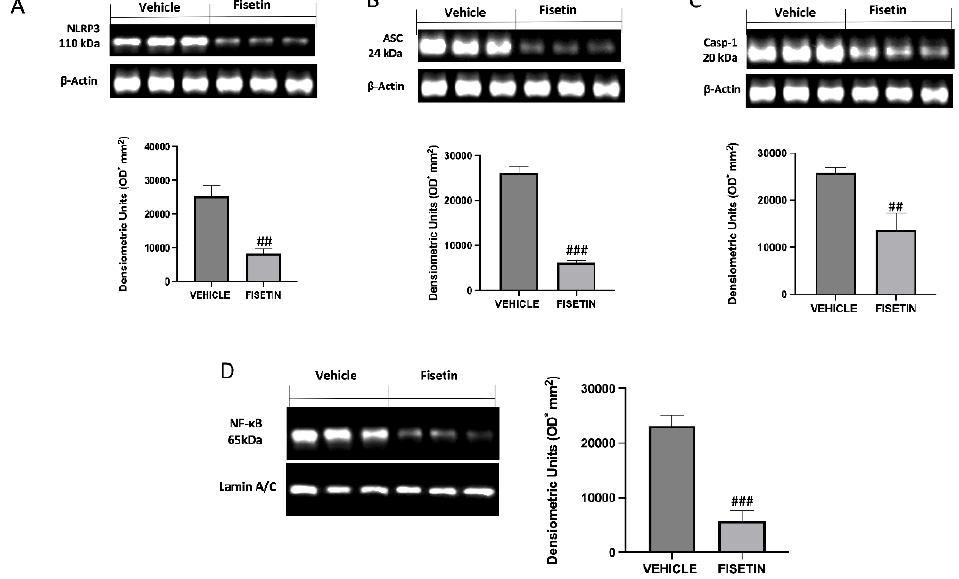
Figure 5. Fisetin administration on inflammasome activation and NF- κ B. Western blots on endometriotic tissues for ( A ) NLRP3, ( B ) ASC, ( C ) caspase 1, ( D ) NF- κ B p65. Exposed is a blot of lysates (6 animals/group) with a densitometric analysis for all animals. The results are means ± SEM of 6 animals for each group. ### p < 0.001 vs. vehicle, ## p < 0.01 vs.